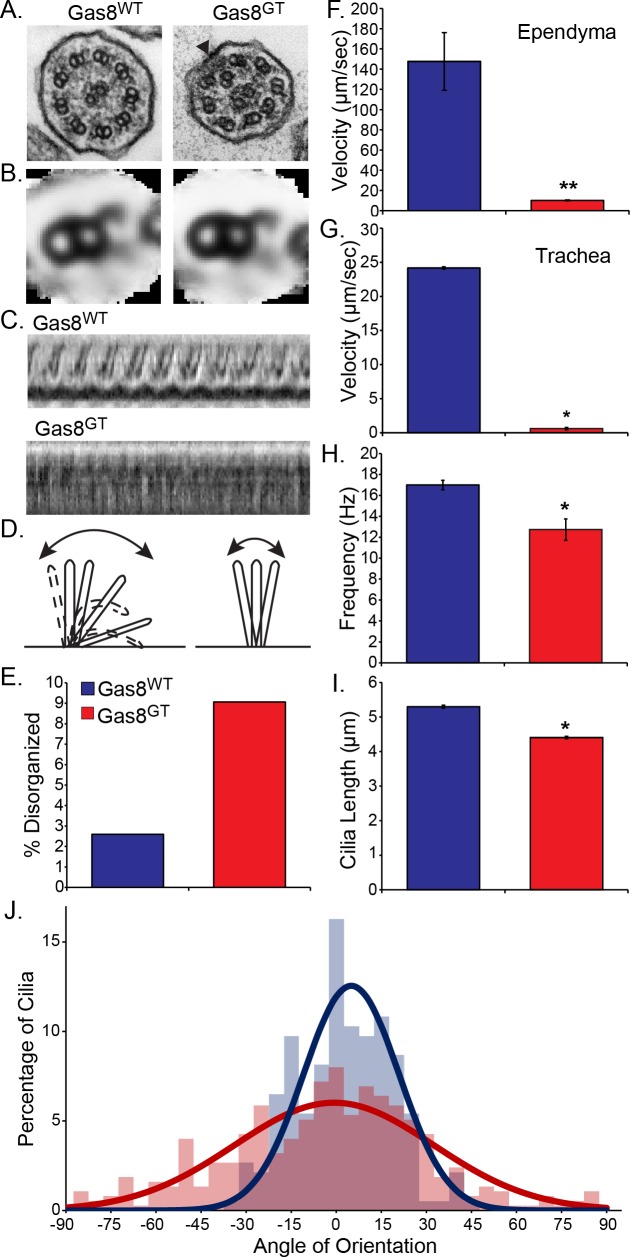
Gas8GT mice present with cilia motility phenotypes.(A) TEM of Gas8WT and Gas8GT tracheal cilia showing disorganized microtubule doublets in mutants. (B) TEM average of tracheal cilia microtubule doublet showing no major structural defects (Gas8WT N = 202 doublets from 1 trachea, Gas8GT N = 202 doublets from 1 trachea). (C) Representative kymograph measurement of ciliary waveform in Gas8WT and Gas8GT tracheal cilia. (D) Schematic depicting waveform defects observed in Gas8GT cilia. (E) Percentage of cilia with disorganized doublets in wildtype and mutant trachea (Gas8WT N = 77 cilia from 1 trachea, Gas8GT N = 287 cilia from 1 trachea). (F and G) Fluorescent bead tracking of Gas8 mice in ependyma and trachea epithelium respectively. Bead flow is significantly impaired in Gas8GT versus Gas8WT Ependyma: Gas8WT = 147.5μm/sec, Gas8GT = 10.2μm/sec (Ependyma: Gas8WT N = 4 brains, Gas8GT N = 4 brains). Trachea: Gas8WT = 24.15μm/sec, Gas8GT = 0.62μm/sec. (Trachea: Gas8WT N = 3 trachea, Gas8GT N = 3 trachea). (H) Tracheal cilia beat frequency (CBF) captured by DIC and analyzed using fast Fourier transform test. Gas8WT CBF = 17.0Hz and Gas8GT CBF = 12.7Hz (Gas8WT N = 108 cilia from 4 trachea, Gas8GT N = 46 cilia from 3 trachea). (I) Cilia length is decreased in Gas8GT mutants as measured from DIC images (p<0.01, Gas8WT N = 321 cilia from 3 trachea, Gas8GT N = 343 cilia from 3 trachea). (J) Cilia orientation is significantly altered in Gas8GT mice (p = 0.025) (Gas8WT N = 184 cilia from 1 trachea, Gas8GT N = 375 cilia from 1 trachea). * = p<0.01, ** = p<0.001